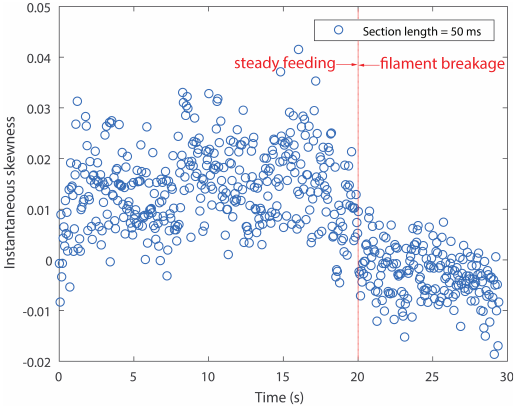
Figure 8. Instantaneous skewness of the AE signal for Test #1 (section length = 50 ms).